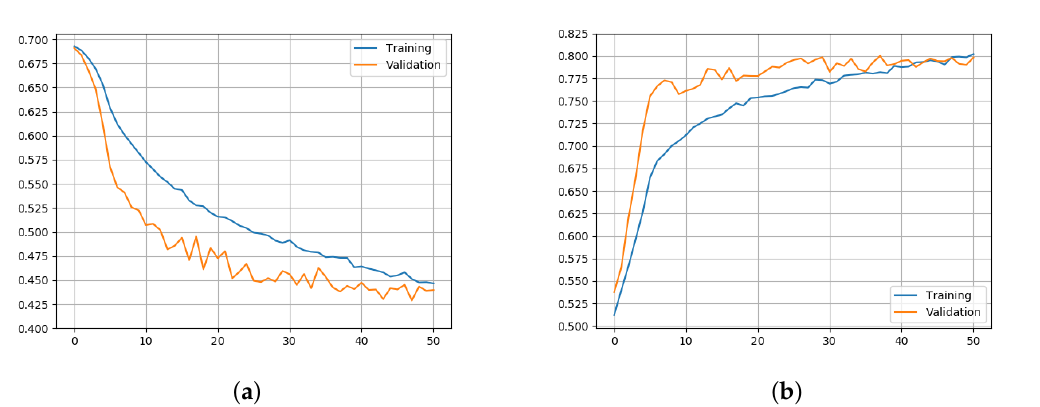
Figure 2. The graph on the left ( a ) shows the evolution of the loss function values during the training (blue) and validation (orange) steps. On the right, ( b ) reports the accuracy (expressed as a percentage in the range [ 0,1 ] ) obtained during the training and validation